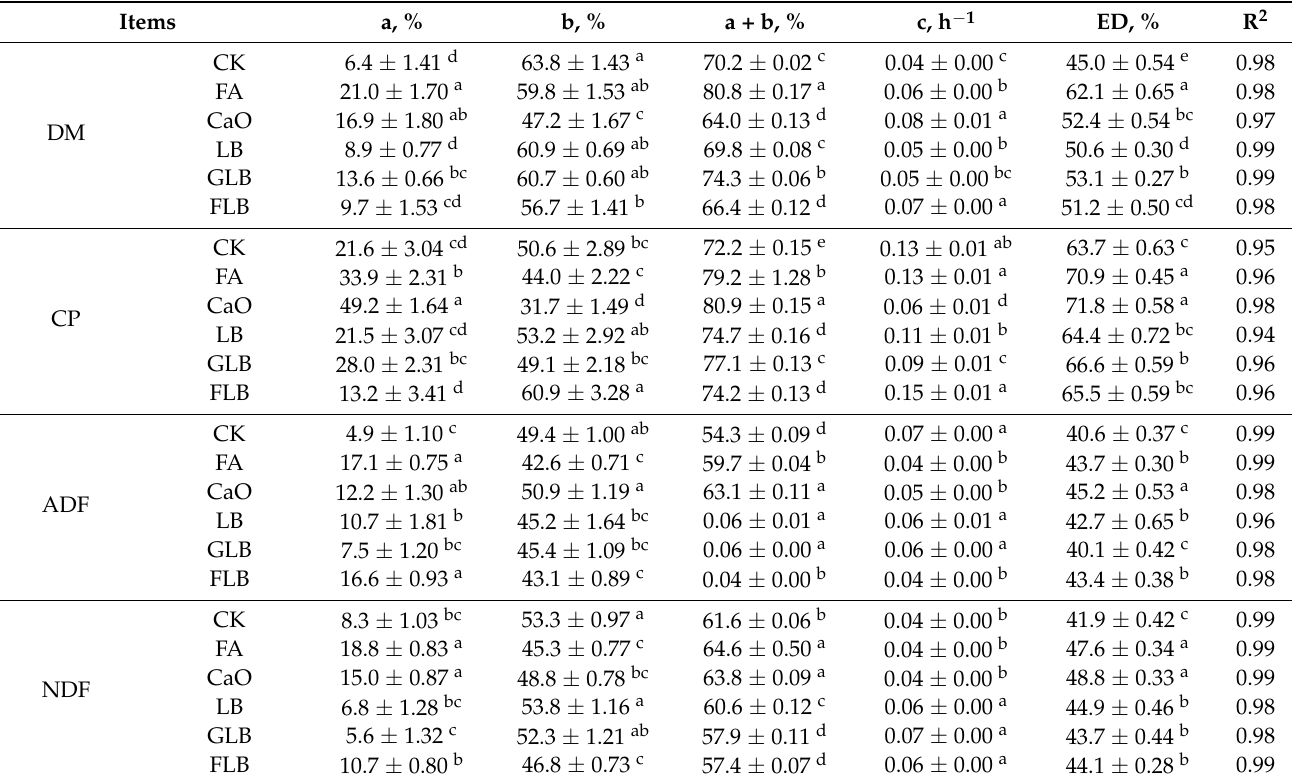
Table 4. Ruminal degradation kinetics of DM, CP, NDF, and ADF of alfalfa